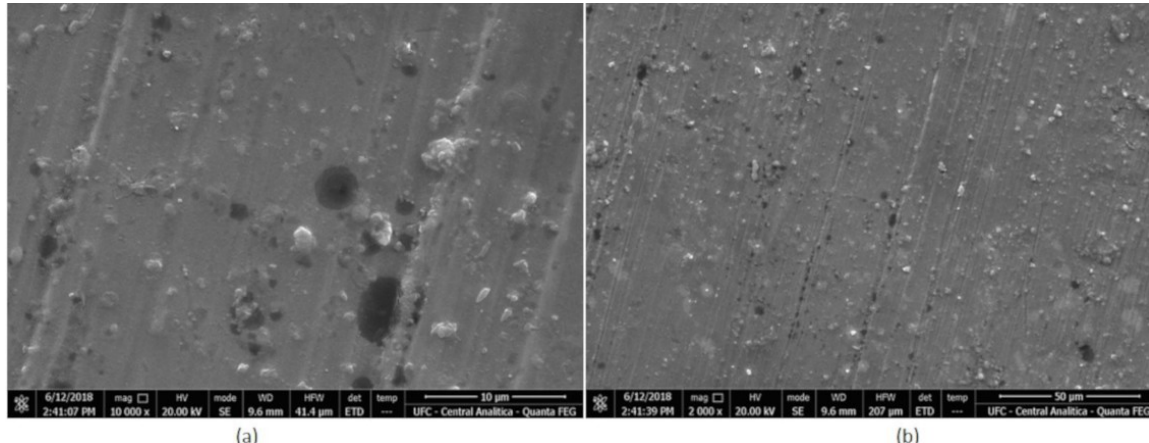
Figure 8: Micrograph of the 100% granite selective surface sample, with magnification factor of: (a) 10000x and (b) 2000x.